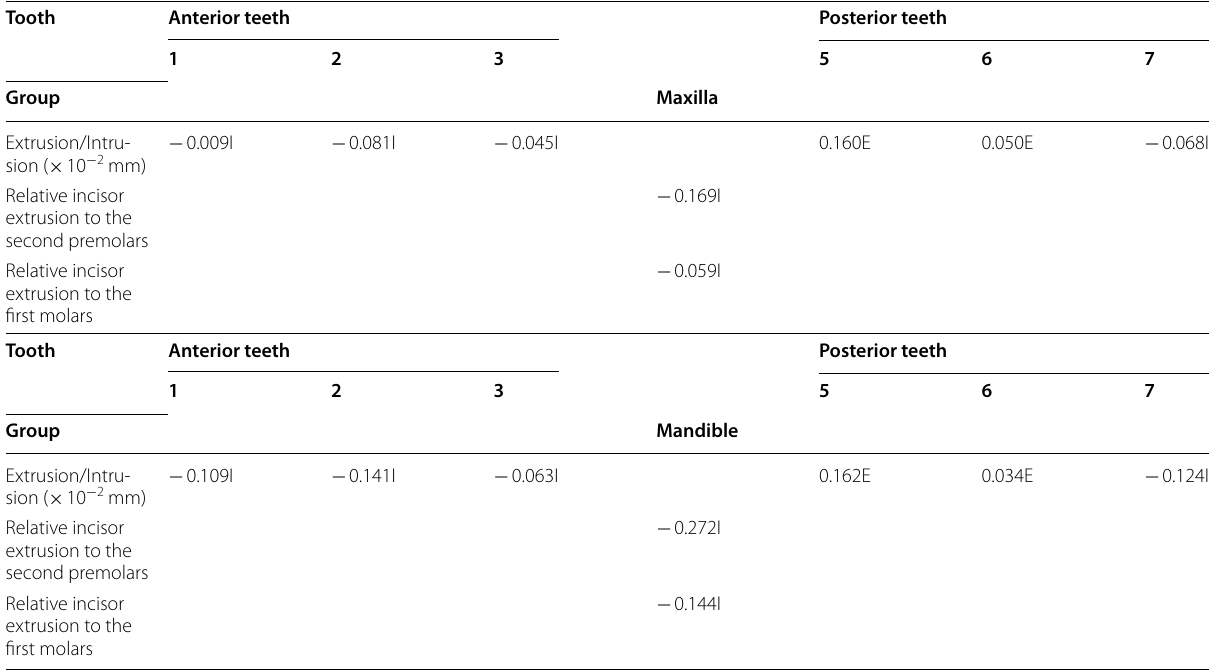
Table 5 Vertical movement of teeth in the 150 g elastic force group